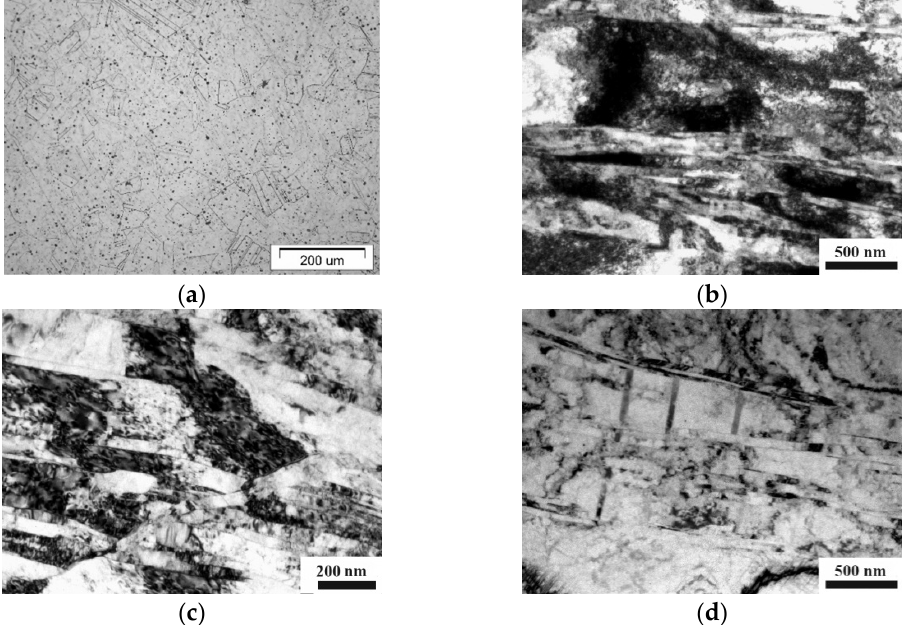
Figure 1. Microstructure of the austenitic steel in the initial state, optical microscopy ( a ) and ECAP-processed state, TEM ( b – d ).